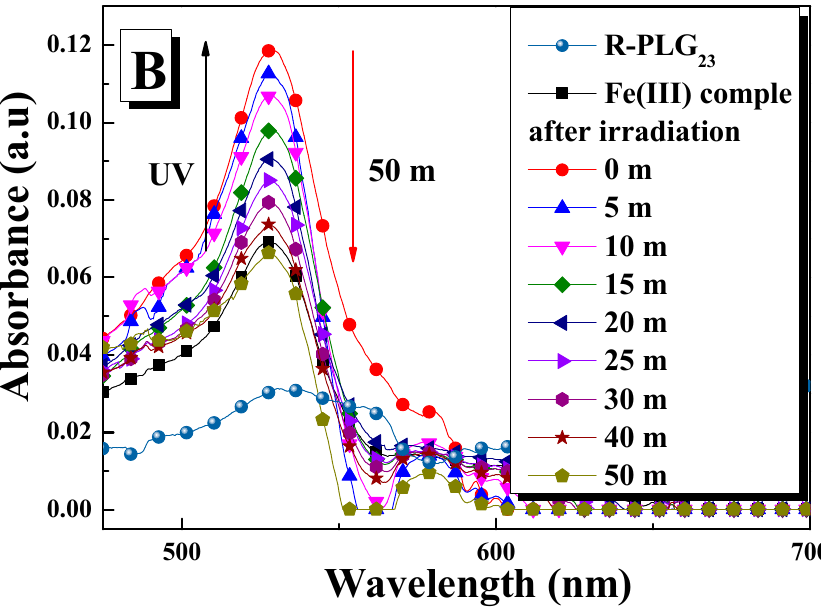
Figure 6. Solution UV absorbance spectra of: ( A ) Sn(II); and ( B ) Fe(III) R–PLG 23 metal complexes after irradiation for different time ([SnCl 2 ] = 10 − 3 M, [FeCl 3 ] = 10 − 3 M and [R–PLG 23 ] = 10 − 4 M in THF).